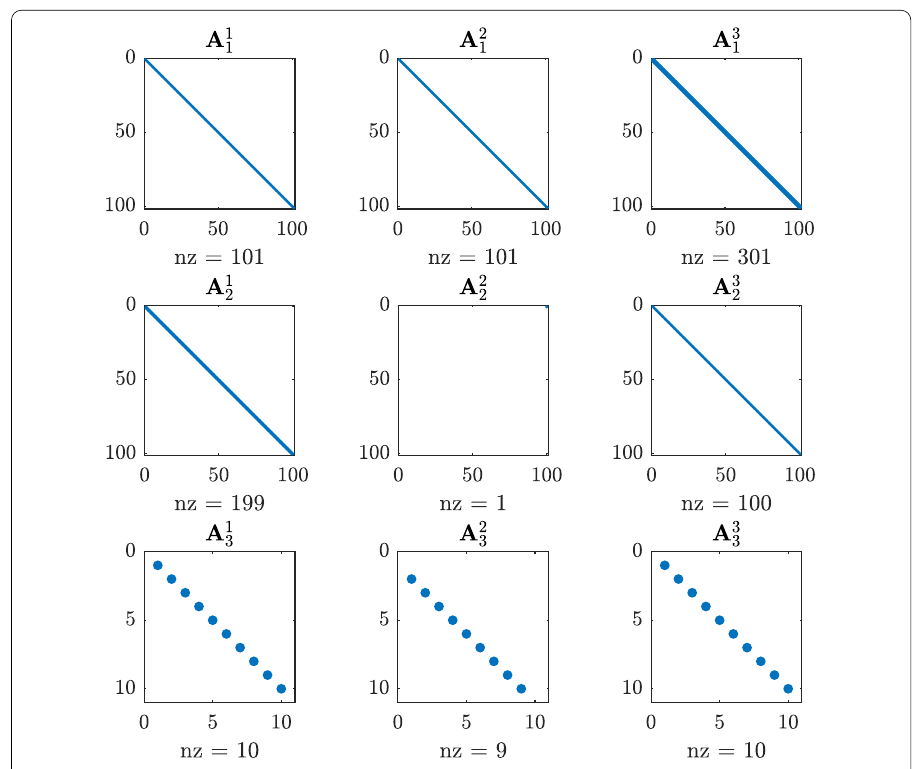
Fig. 4 Sparsity pattern of the discrete PGD operators associated with the separated representation (22), for N x = 101, m + 1 = 100 and M =